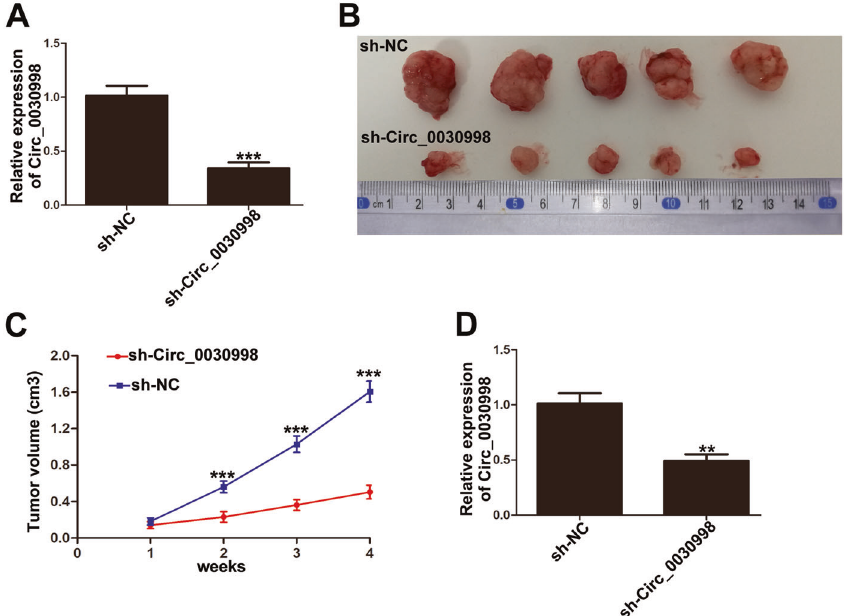
Fig. 4 The effect of Circ_0030998 on CRC growth in vivo. A The ef fi ciency of sh-Circ_0030998 in SW480 cells examined by qRT-PCR. B The tumor tissues from nude mice of SW480/sh-NC and SW480/sh-Circ_0030998 groups. C The tumor volumes in two groups were evaluated every week until 4 weeks. D The relative expression of Circ_0030998 in tumor tissues from two groups detected by qRT-PCR. ** p < 0.01, *** p <